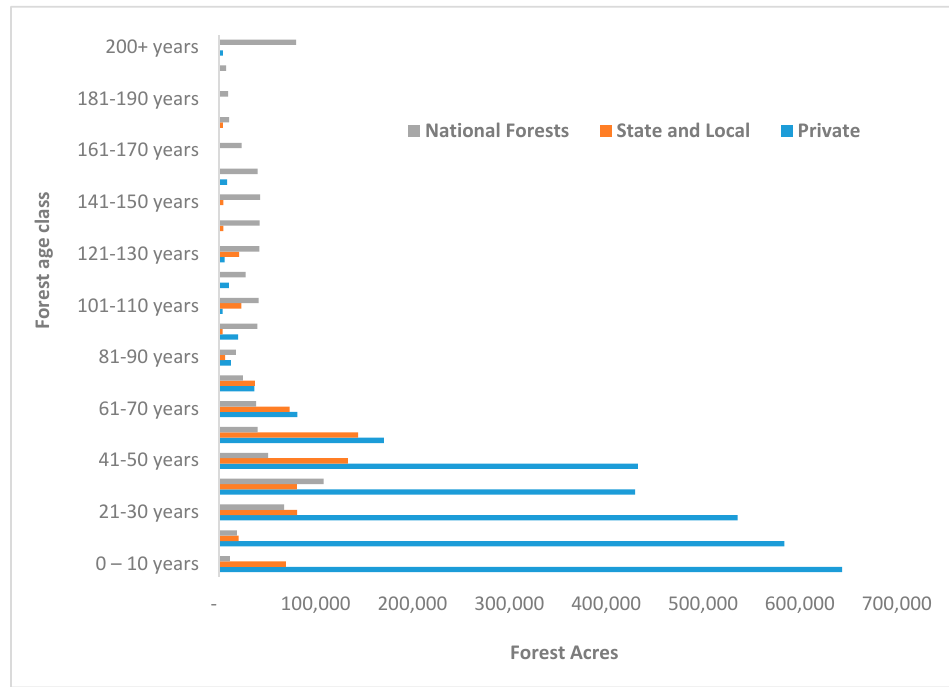
Figure 4. Age class distribution in the Oregon Coast Range as of 2016 arranged by ownership class.